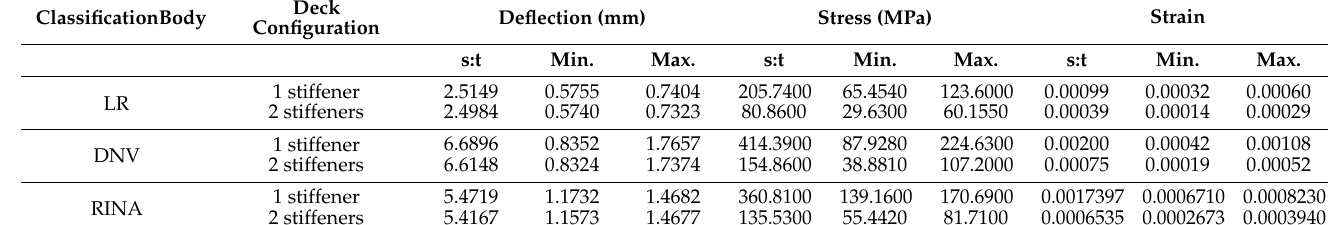
Table 4. Outputs of the FE analyses performed under the UDL condition.